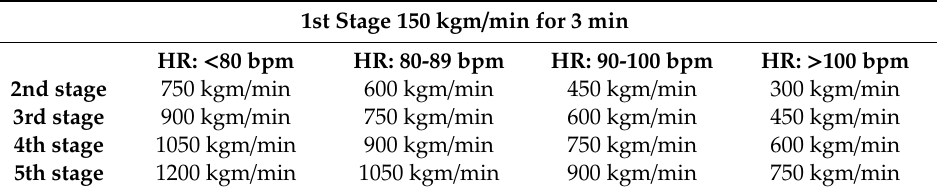
Table 3. YMCA adapted fitness protocol used for setting personalized HIIT